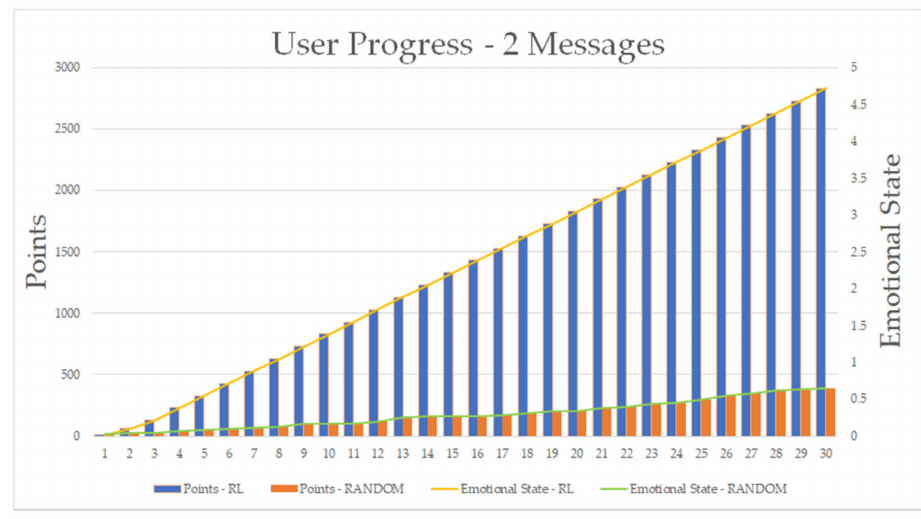
Figure 9. Simulation Results—1st Scenario.